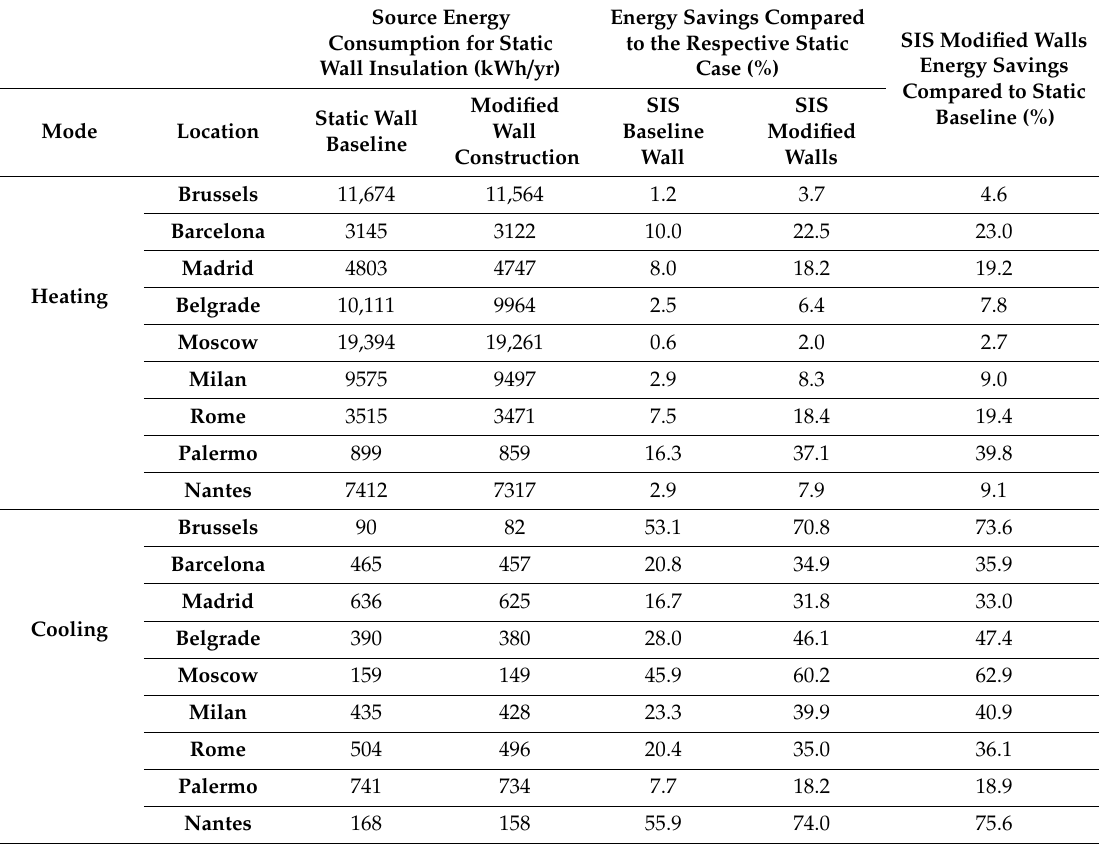
Table 13. Annual heating and cooling energy consumption of the prototypical detached house in European climates with static insulation and the savings obtained when applying SIS to the baseline and optimized wall